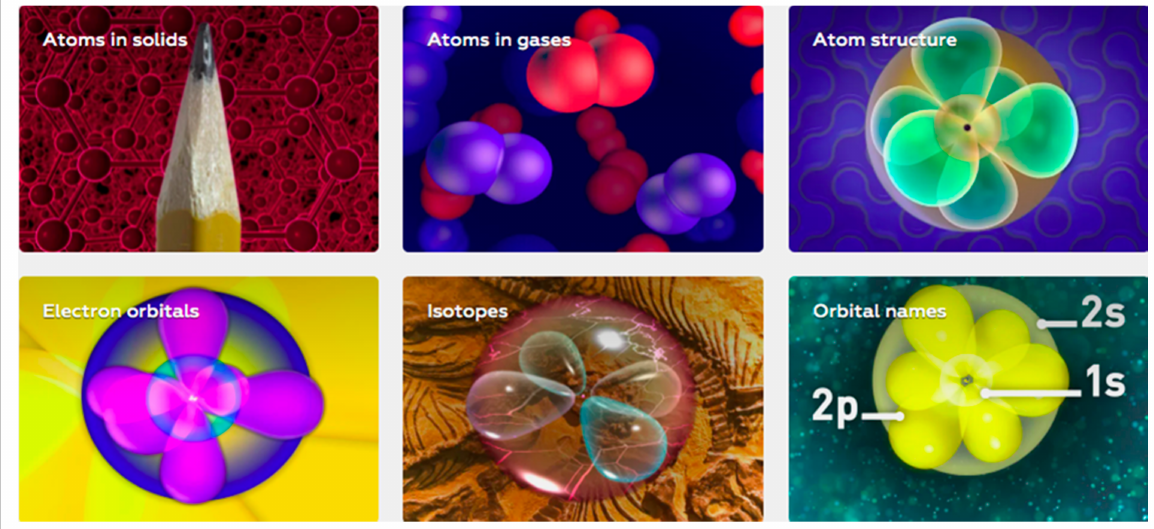
Figure 1. Contents of the courses in the Mel Chemistry